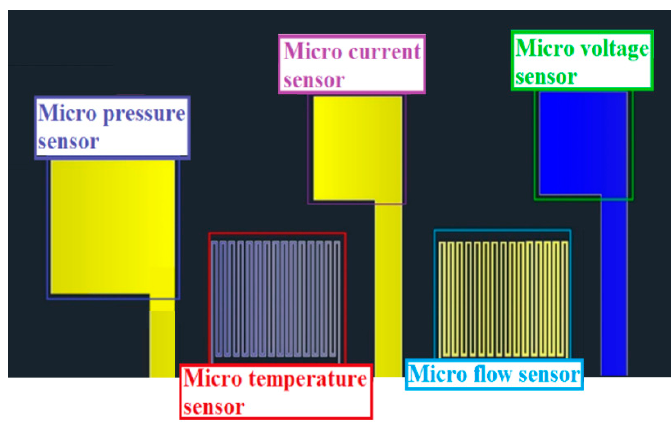
Figure 5. Integrated design drawing of flexible five-in-one microsensor.